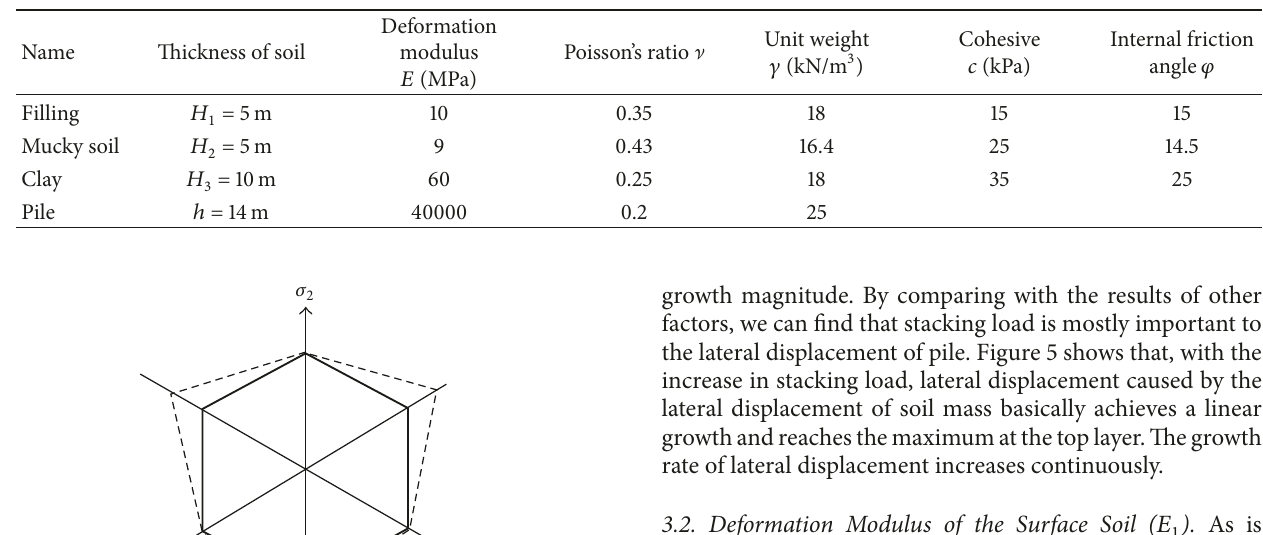
Table 1: Information of soil.